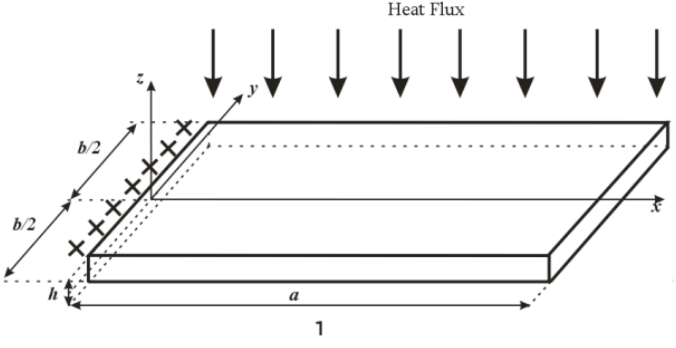
Figure 1. The temperature shock scheme.